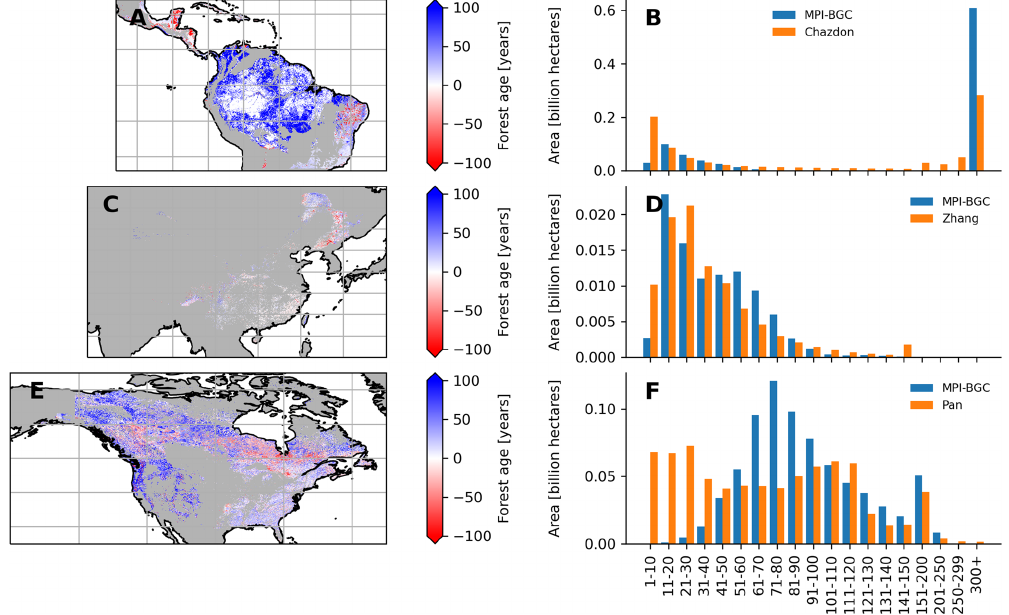
Figure 9. Comparison between the forest age dataset from this study and an independent forest age dataset: Amazon basin ( a and b ), China ( c and d ) and North America ( e and f ). For a fair comparison with the independent age datasets, the MPI-BGC forest age map used here is the one without tree cover correction applied to the agb dataset. Differences were computed using weighted age estimates from the fraction of the decadal age classes within each 0.5 ◦ grid-cell